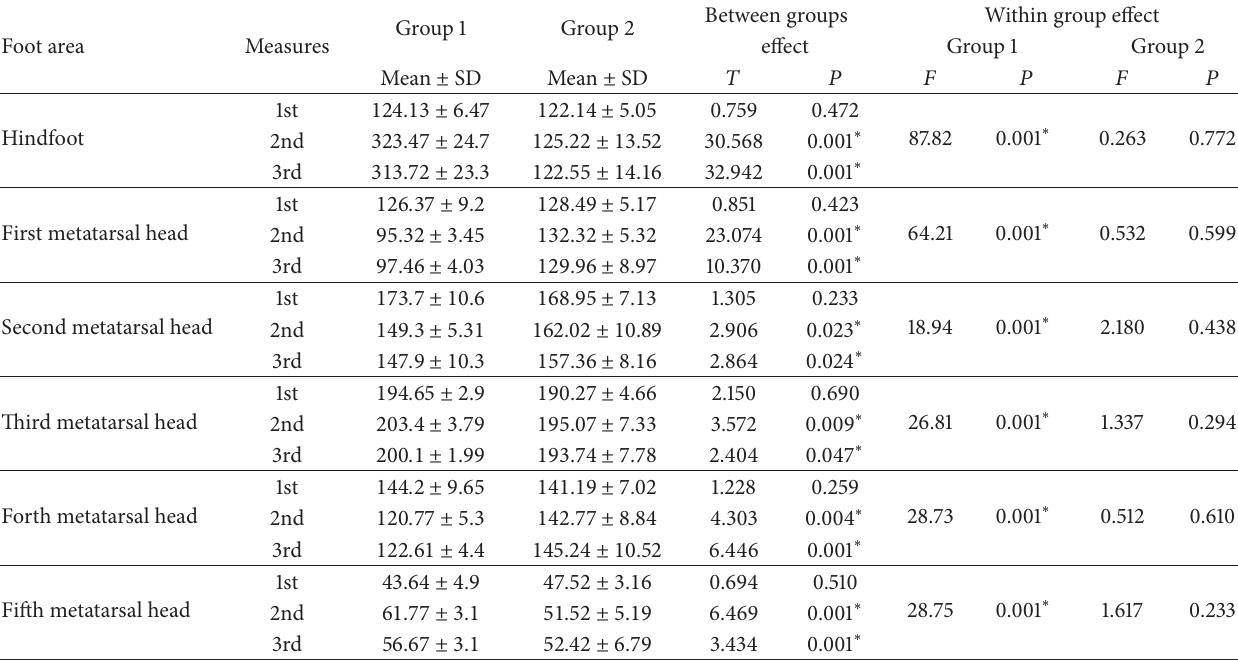
Table 4: Mean scores of maximum force (N/cm 2 ) for the study and control groups and the associated 𝑃 values for test of